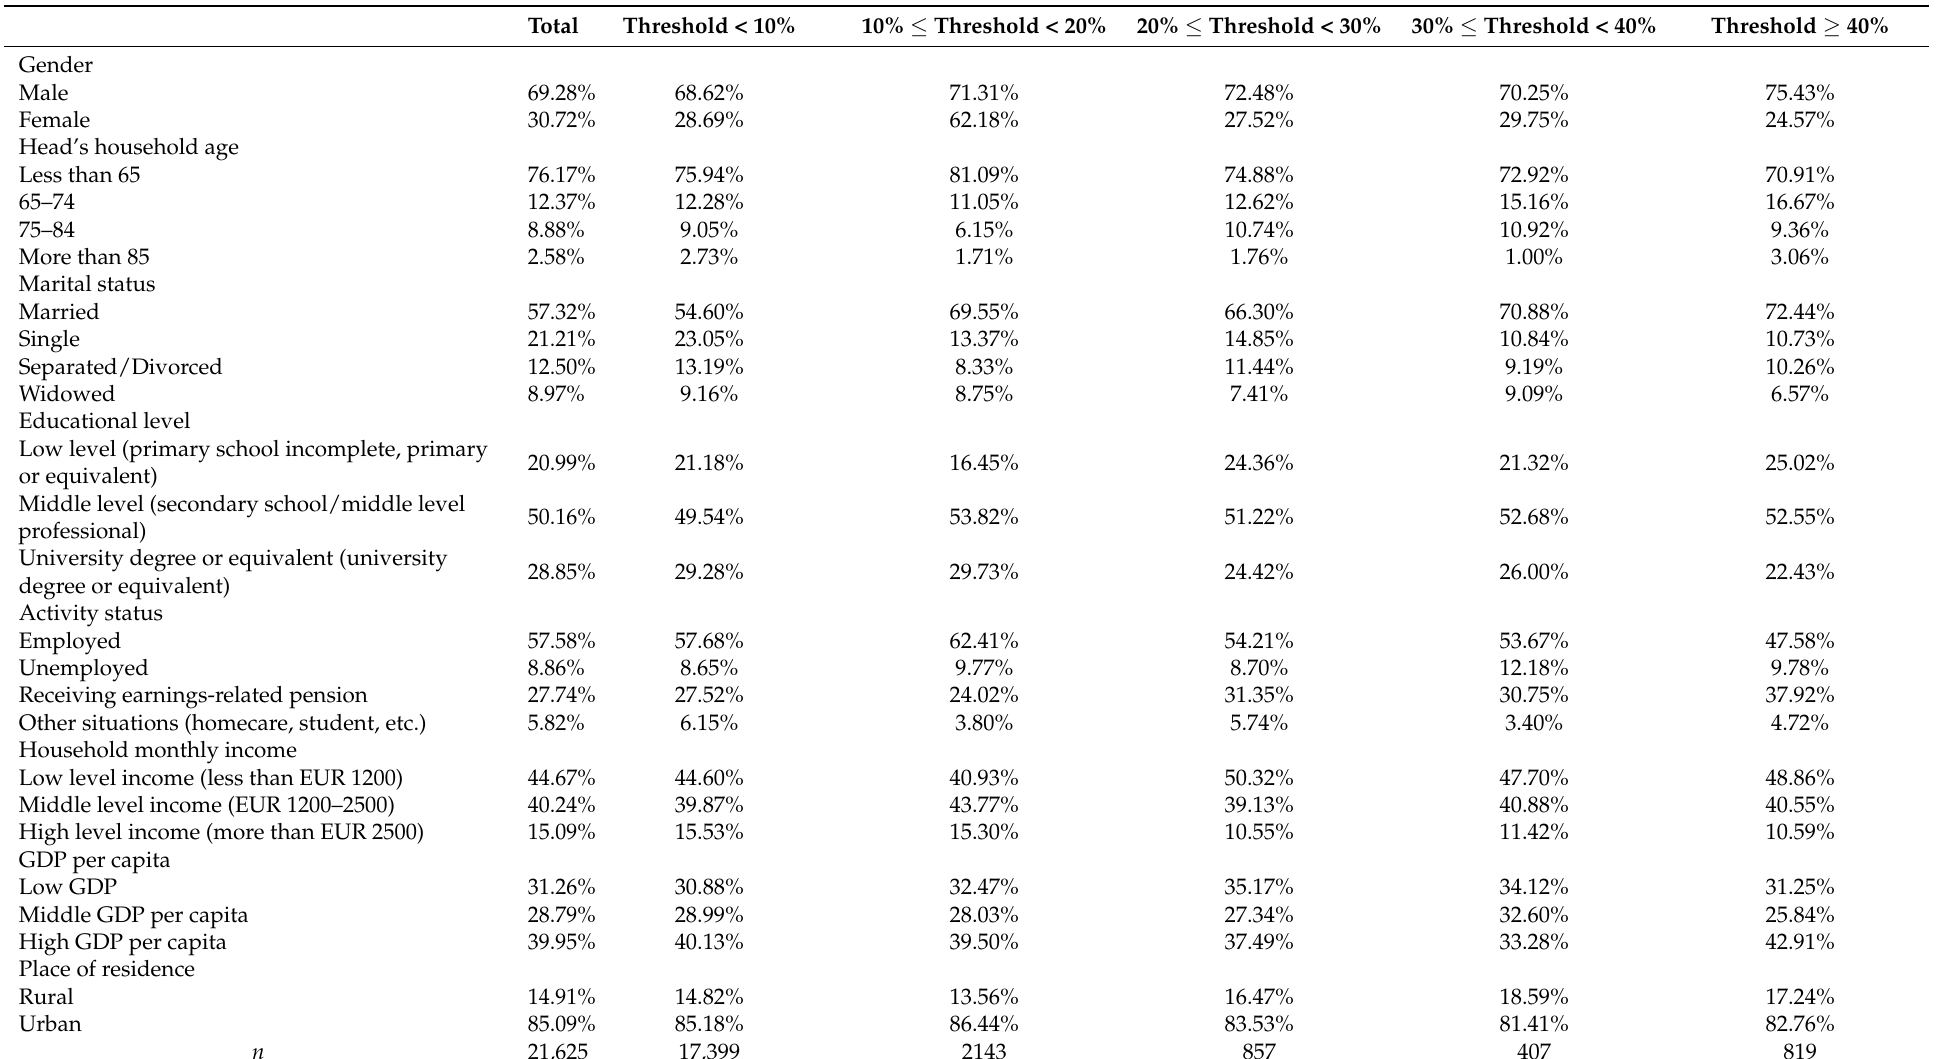
Table 2. Descriptive statistics of the sociodemographic variables of households in Spain based on the percentage of resources they dedicate to health payments. Year